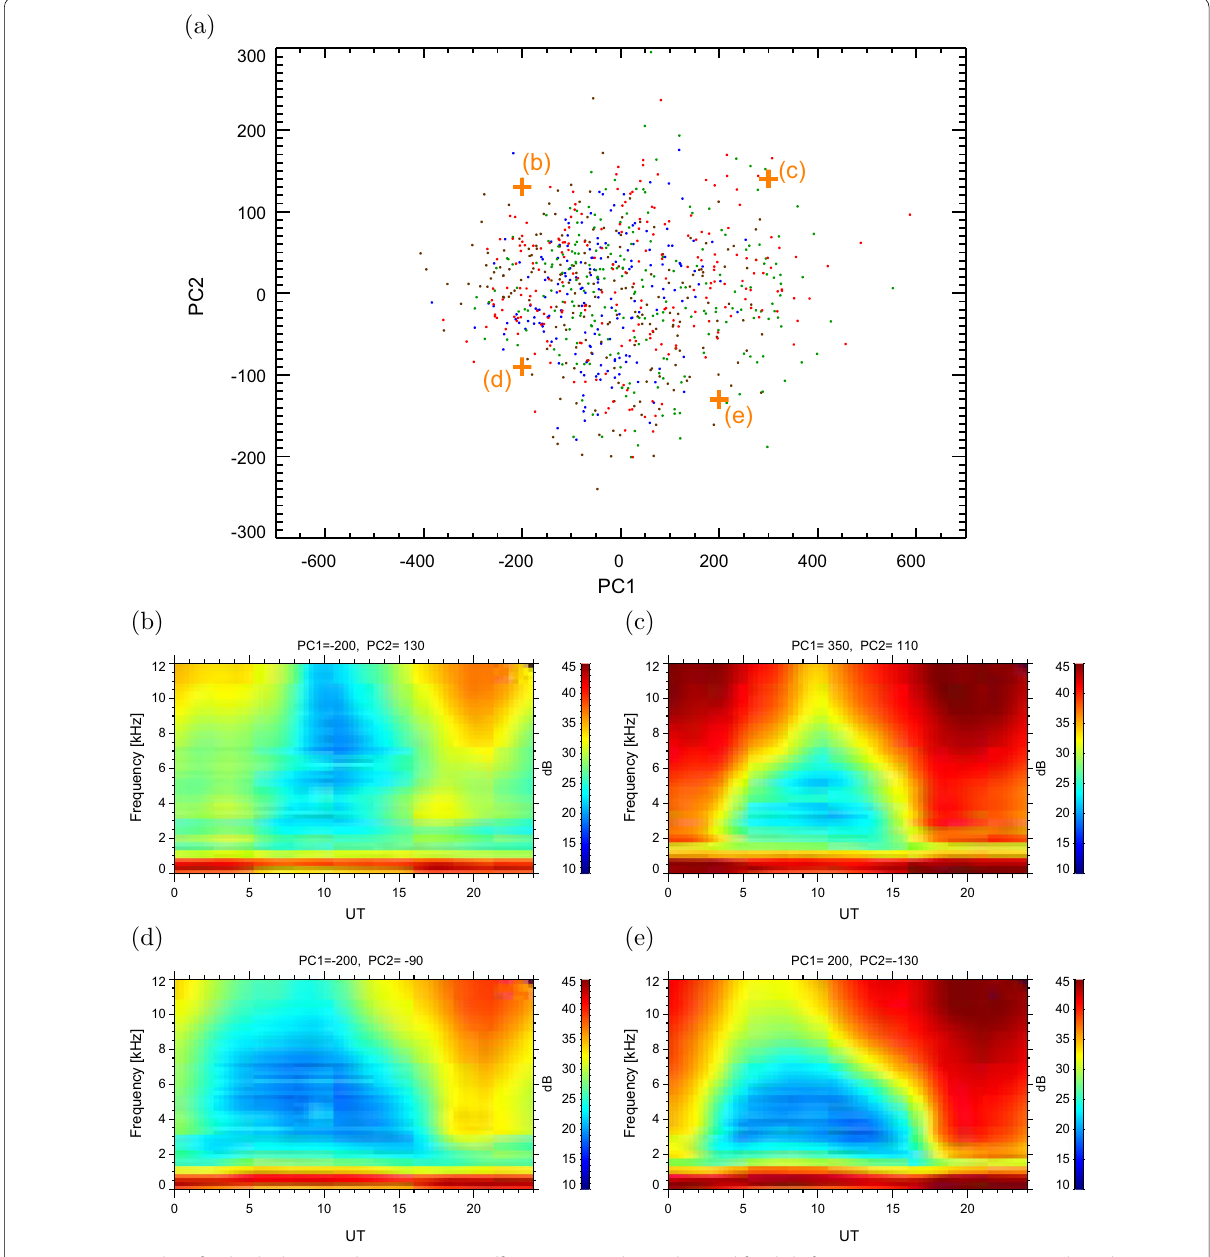
Fig. 2 a Scatter plot of individual principal component coefficients PC1 and PC2 obtained for daily frequency–time spectrograms. The colors of points distinguish individual Kannuslehto campaigns—blue points correspond to the 2016/2017 campaign, brown denote the 2017/2018 campaign, green indicate the 2018/2019 campaign, and red points were measured during the 2019/2020 campaign. b – e Frequency–time spectrograms obtained using the first two principal component coefficients. Their coordinates are plotted in a by orange crosses and correspond to b [-200, 130], c [350, 110], d [-200,-90], e